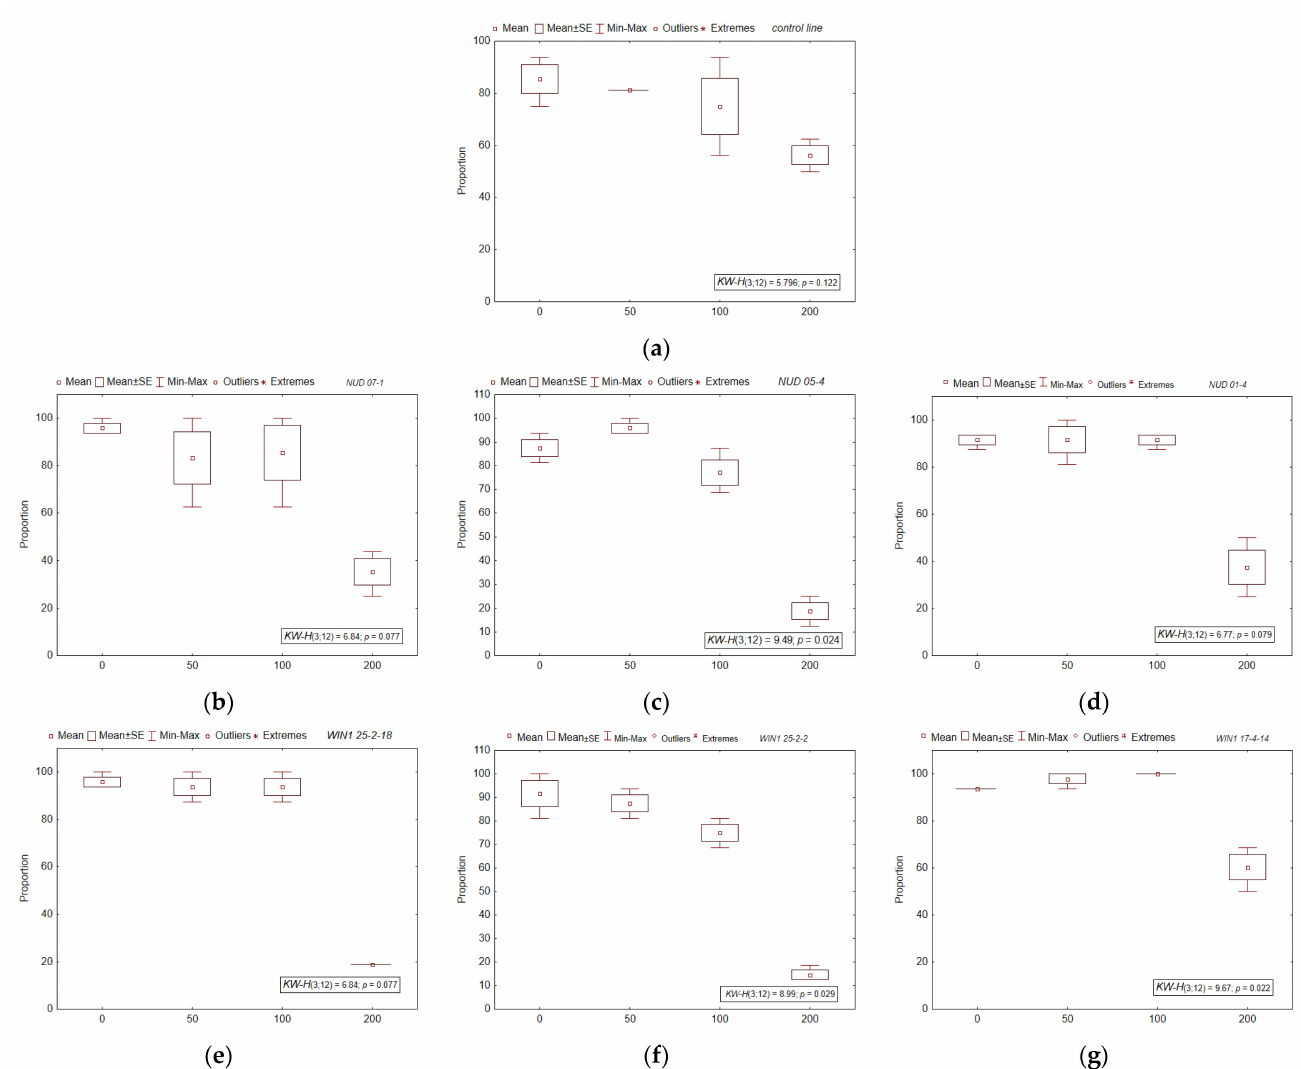
Figure 3. The proportion of seedlings with leaves in KO barley lines after irradiation. ( a ) WT, ( b ) nud 07-1 , ( c ) nud 05-4 , ( d ) nud 01-4 , ( e ) win1 25-2-18 , ( f ) win1 25-2-2 , and ( g ) win1 17-4-14 . The x -axis indicates radiation doses (Gy). The number of samples for each dose or line was N = 3. The mean, standard error (SE), minimum (min) and maximum (max) values are indicated in the Figure 3. The nonparametric Kruskal-Wallis (KW) method was used, where H is the criterion value, p -value is the significance level. The degree of freedom ( df ) values of the numerator and denominator of H -criterion are given in